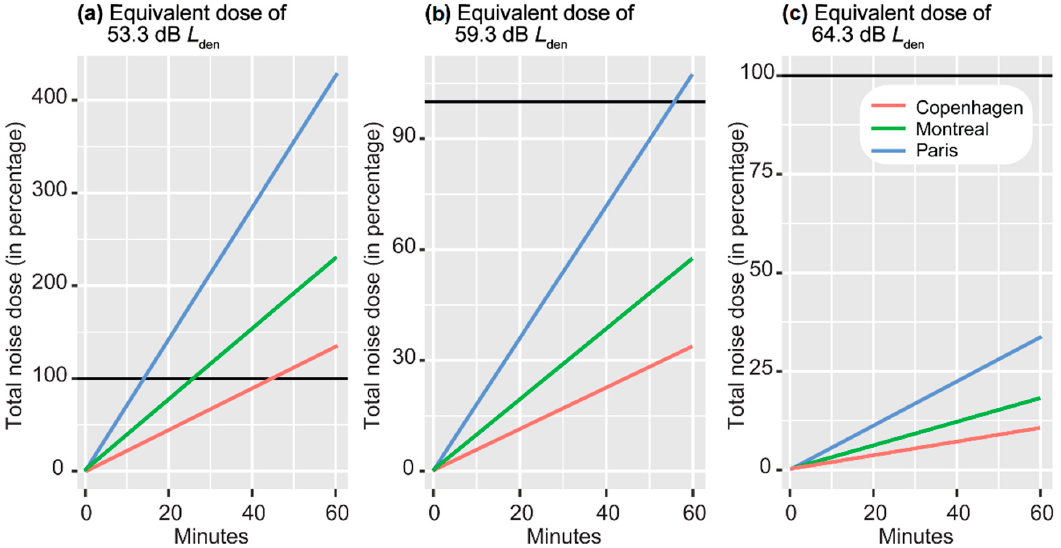
Figure 7. Total noise dose (in percentage) according to cycling duration (in minutes) for three cutoff values (( a ) 53.3 db L den , ( b ) 59.3 db L den , and ( c ) 64.3 db L den ) by city. The black horizontal line represents the 100% dose with an exposure of 53.3 dB ( a ), 59.3 dB ( b ), and 64.3 dB ( c ) during 24 h.